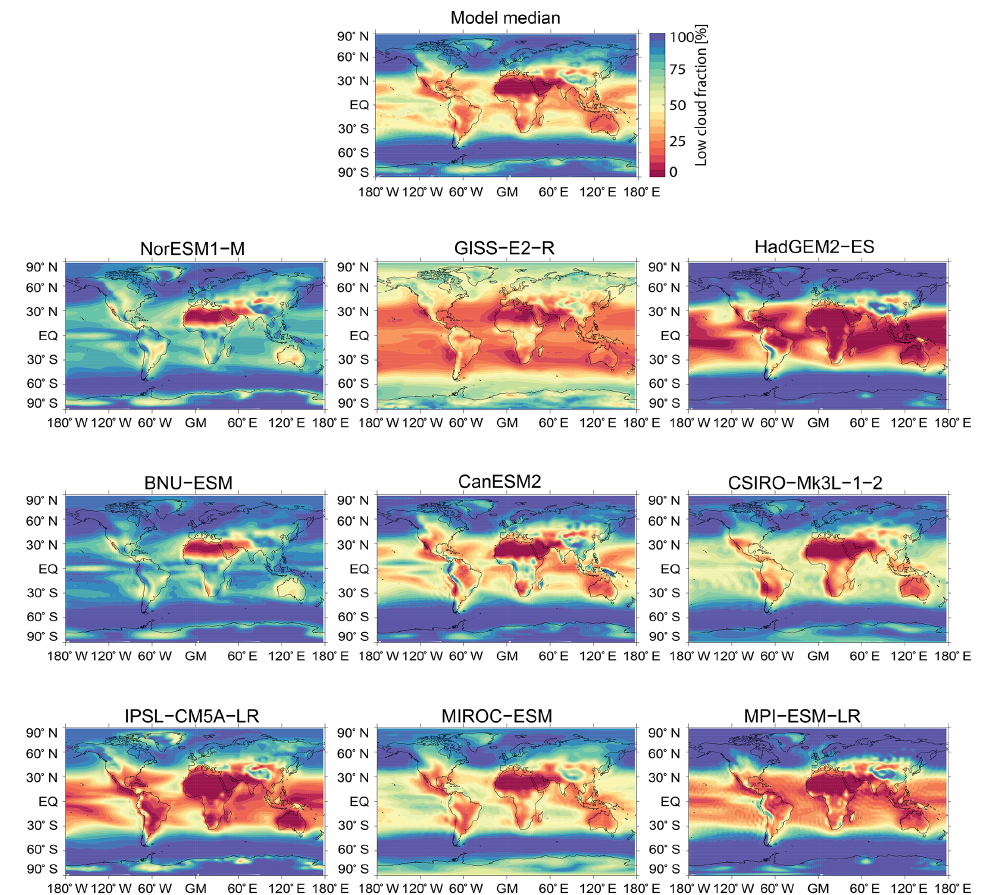
Figure 2. Low cloud fraction (%) for the first 20 years of the RCP4.5 scenario, for the model median as well as the individual models. Low clouds are estimated using a random overlap assumption (Tian and Curry,